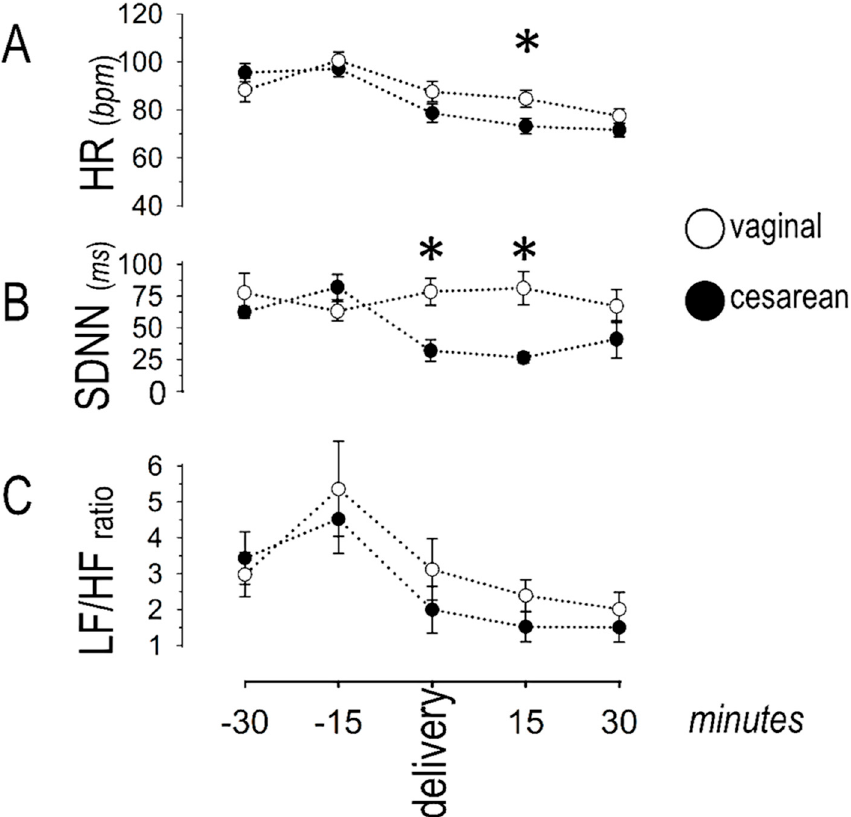
Figure 3. Sympatho-vagal balance; ( A ) except from the 15th minute post-delivery (asterisk), heart rate (HR, in beats per minute) was similar in the two groups; ( B ) the standard deviation of consec- utive sinus inter-beat intervals (SDNN) was lower around cesarean delivery and 15 min thereafter (asterisks); ( C ) the low (LF) to high (HF) frequency band was similar in the two groups. Asterisks denote significant ( p <0.05) differences between groups.